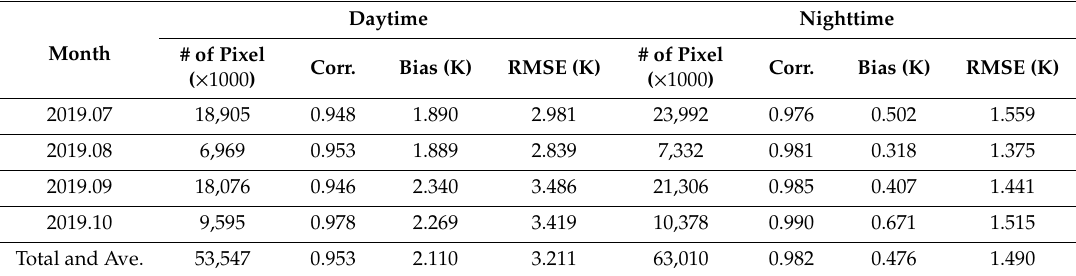
Table5. ComparisonresultsoftheGK2ALSTdataandtheMODISLSTdata(Collection6)fortheselected four months, according to the daytime and nighttime (July, August, September, and October